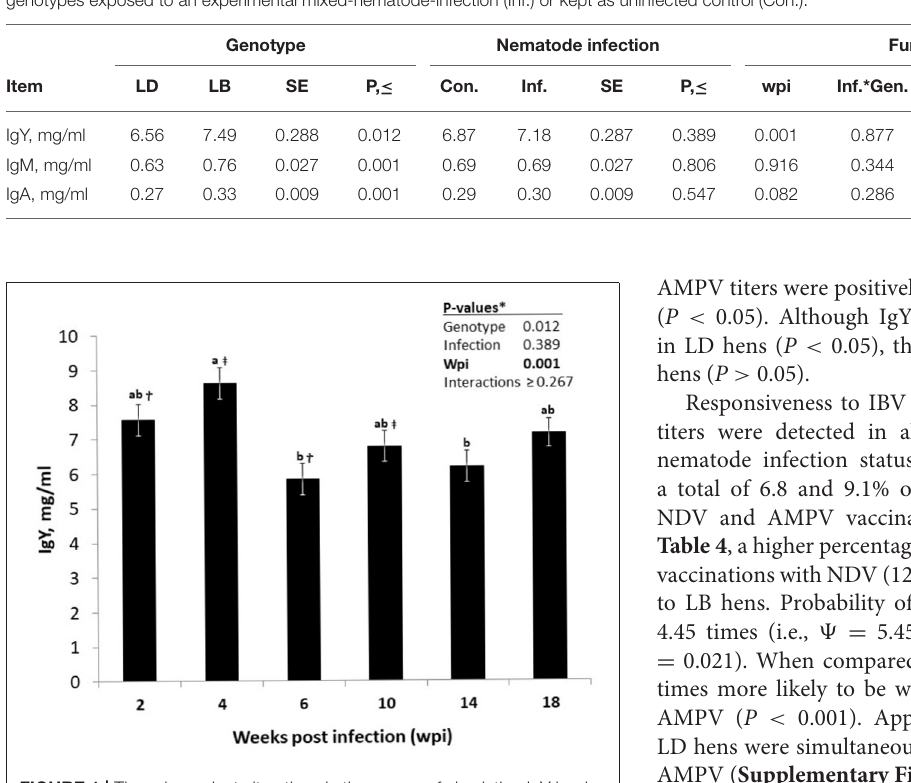
FIGURE 1 | Time-dependent alterations in the course of circulating IgY levels in infected or uninfected hens of Lohmann Brown Plus and Lohmann Dual genotypes over the experimental period. * For the significant genotype differences as well for the non-significant P- values for all possible interaction effects see Table 2 . ab Different letters indicate significant differences between different time points ( p < 0.05). † Time points (wpi) sharing the sign tend to differ ( p = 0.086). ‡ Time points (wpi) sharing the sign tend to differ ( p =